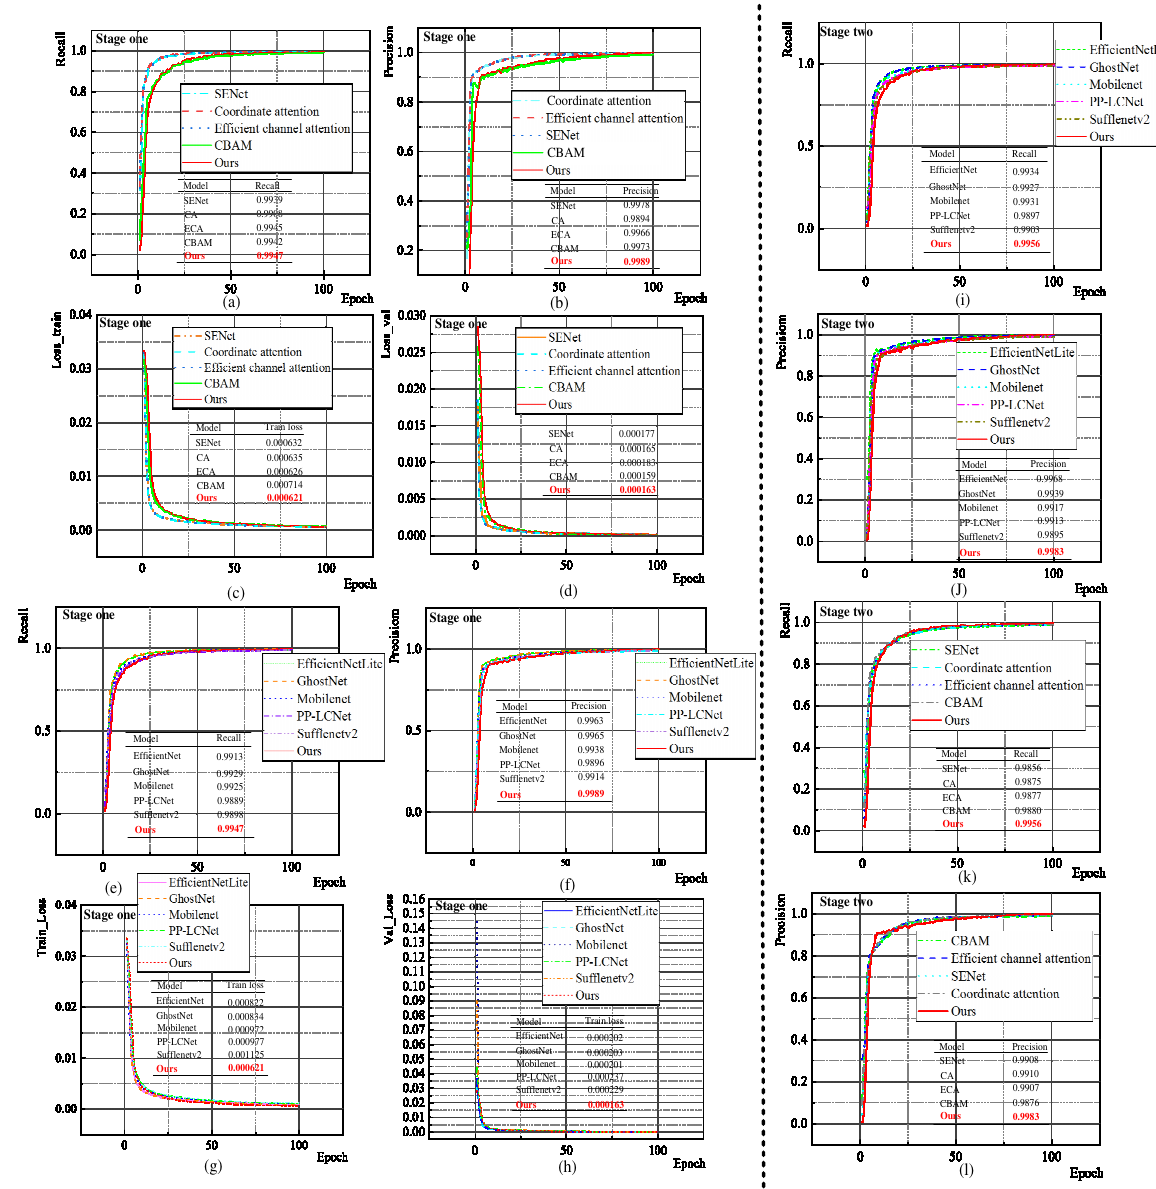
Figure 14. The first stage model detection performance comparison. In Figure 14a–d, the four attention network structures including SENet, Coordinate attention, Efficient channel attention and CBAM components were added to the backbone of YOLOv5, respectively. Figure 14a shows that recall performs best among all models with the attention mechanism, reaching 99.47%, and precision in Figure 14b was 99.89%, which was better than other models. The performance of the curve with the CBAM mod- ule improved slowly in the first 50 epochs, which was lower than other models, however, good accuracy was achieved in the later stage. The CBAM components were embedded in the backbone and neck part of YOLOv5 in our Double-attention YOLO model. The at- tention deployment on the whole network fully offsets the precision performance loss caused by the introduction of GhostNet model pruning and ViT module. Figure 14c,d shows the training and validation loss function curves of several models. It shows that the overall decline process of loss function obtained by our method was